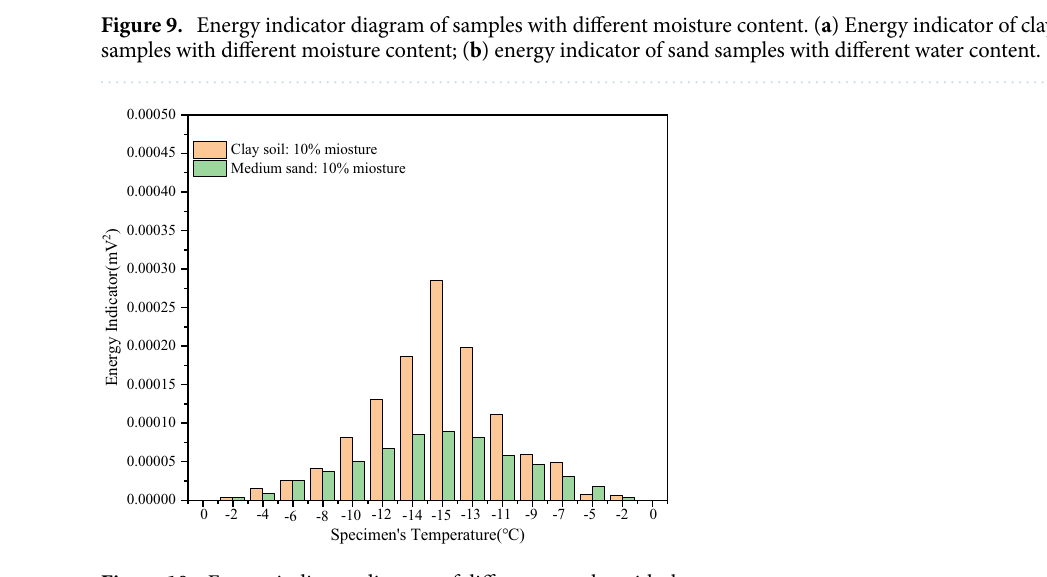
Figure 10. Energy indicator diagram of different samples with the same water